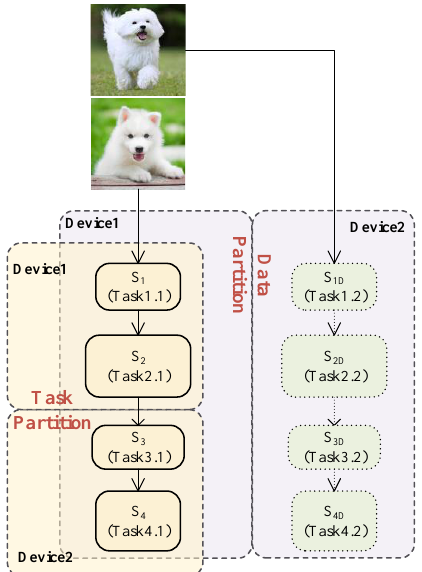
Figure 1. Illustration of workload partitioning approaches.